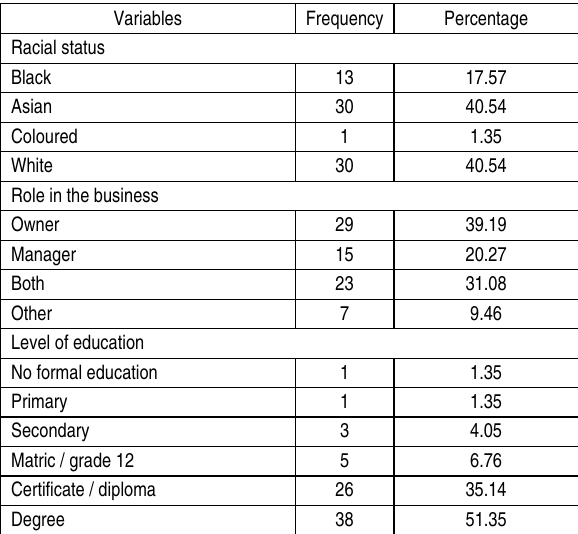
Table 2 (cont.). Socio-demographic information of the participants